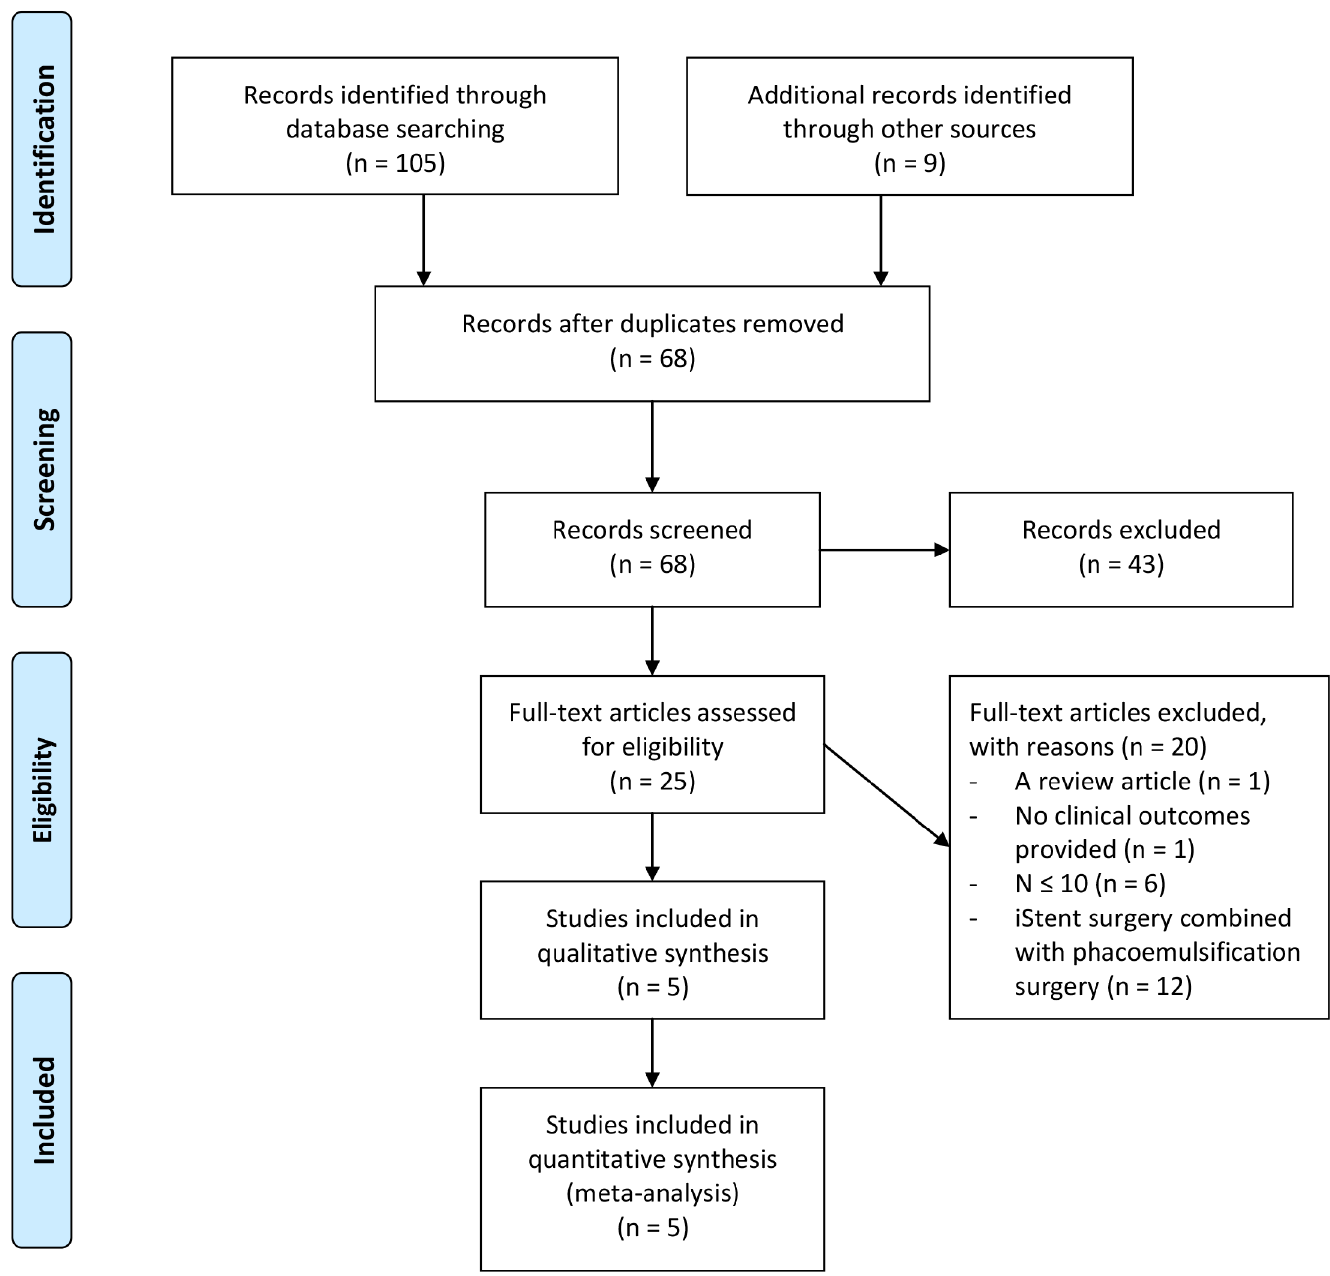
Fig 1. PRISMA Flow Diagram for iStent as a Solo Procedure for Patients with